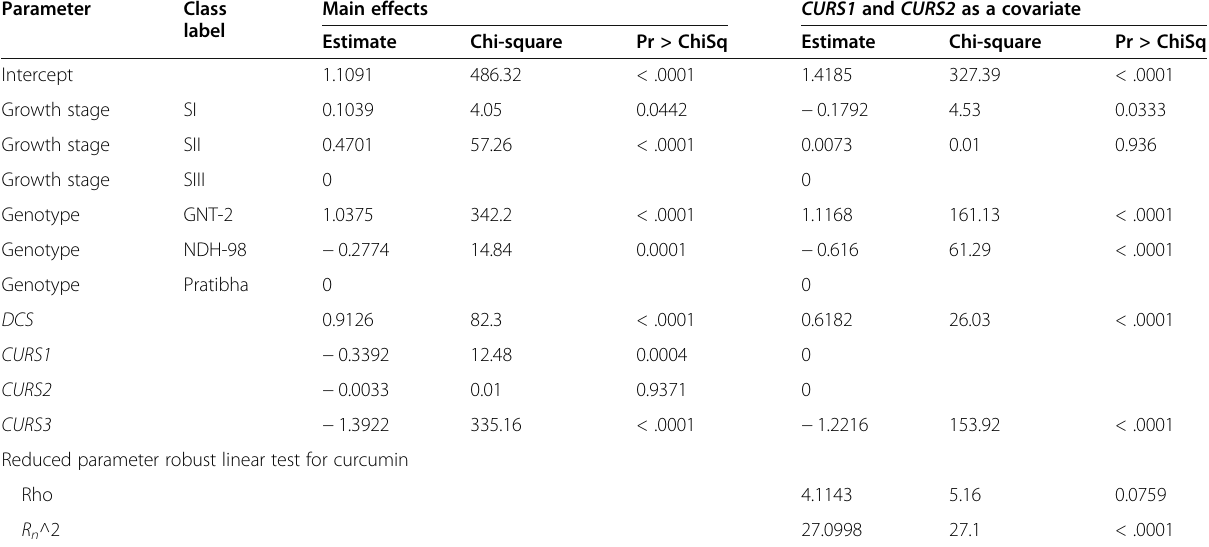
Table 3 Association-based test of DCS and multiple curcumin synthases with curcumin